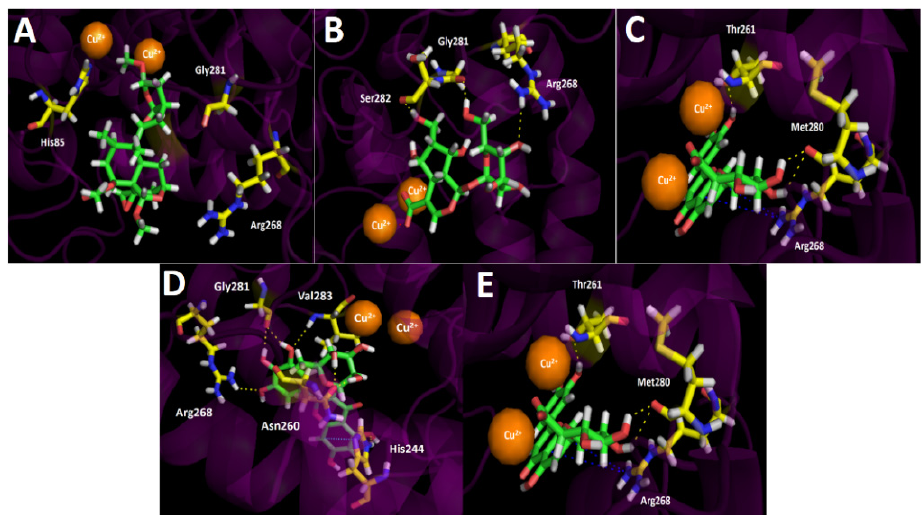
Figure 6. Predicted binding mode and predicted intermolecular interactions of the selected major compounds in Gaultheria pumila berries extract and the residues of the Agaricus bisporus mushroom tyrosinase catalytic site. Yellow dotted lines indicate hydrogen bond interactions, cyan dotted lines represent π – π interactions, red dotted lines indicate salt bridge interactions, and blue dotted lines indicate π -cation interactions. ( A ) Scupolin I in the catalytic site; ( B ) Unedide in the catalytic site; ( C ) Nuzhenal B in the catalytic site; ( D ) Myricetin O -rhamnoside in the catalytic site; and ( E ) Luteolin 7-glucuronide in the catalytic